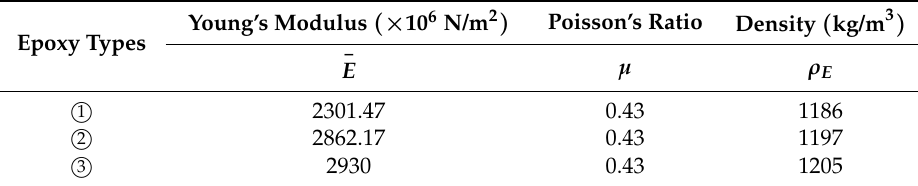
Table 2. Material parameters of three types of epoxy